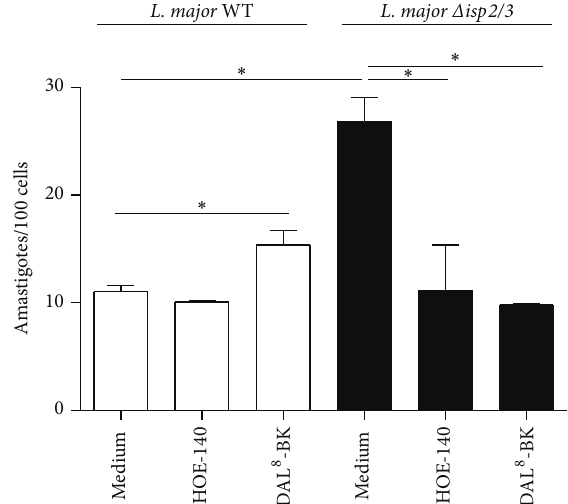
Figure 2: Differential role for bradykinin receptors in the phago- cytic response of macrophages infected by WT L. major pro- mastigotes and Δ𝑖𝑠𝑝2/3 mutants. Thioglycolate elicited (peritoneal) macrophages were incubated in medium containing 1 mg/mL BSA in the presence or absence of 100 nM of HOE-140 or 1 𝜇 m of des-Arg 9 -[Leu 8 ]-BK (DAL 8 -BK). Promastigotes were added (para- site/cellratio5 :1)andincubatedfor3 hat37 ∘ C.Whitebarsrepresent L. major WT and black bars represent Δ𝑖𝑠𝑝2/3 . Data represent numbers of intracellular amastigotes per 100 macrophages (means ± SD) for triplicates and represent two different experiments ( ∗ 𝑃 < 0.05